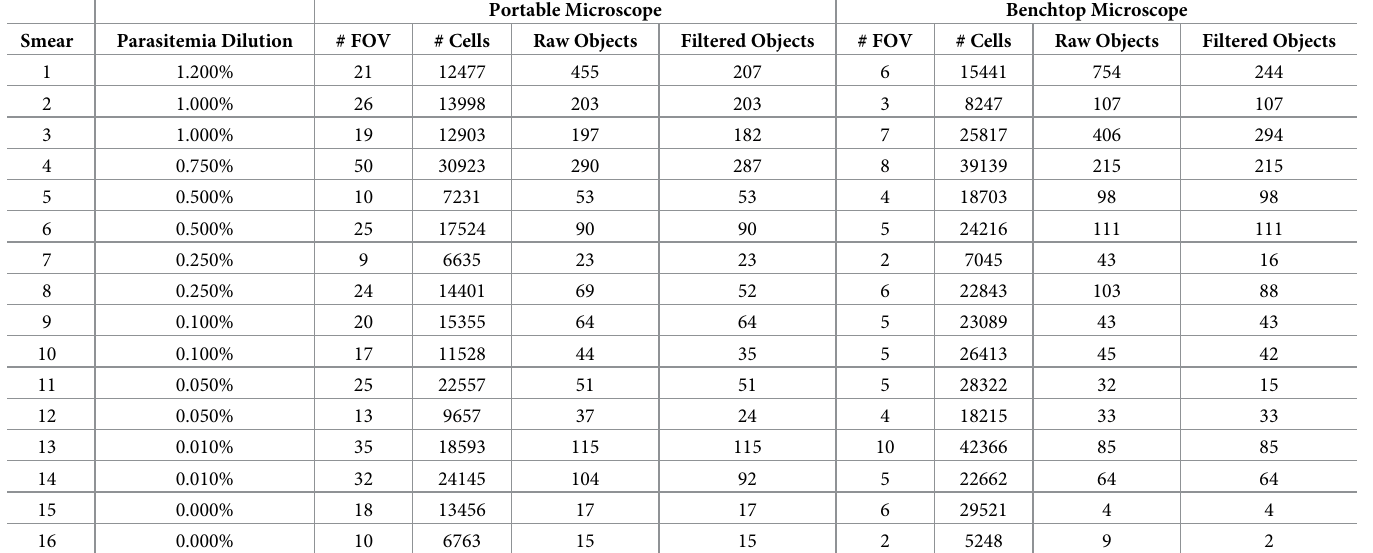
Table 1. Sample sizes of all smears, cells, and fluorescent